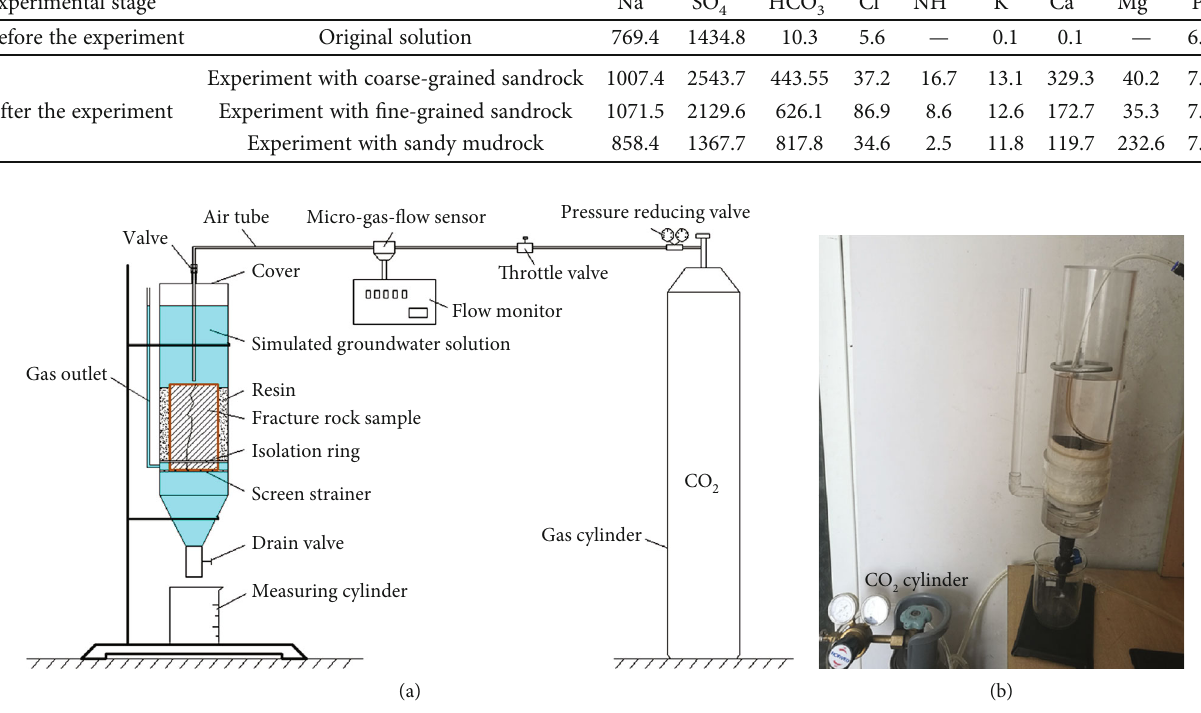
-rock interaction (WCRI) experiment. (a) Illustration. (b) 2